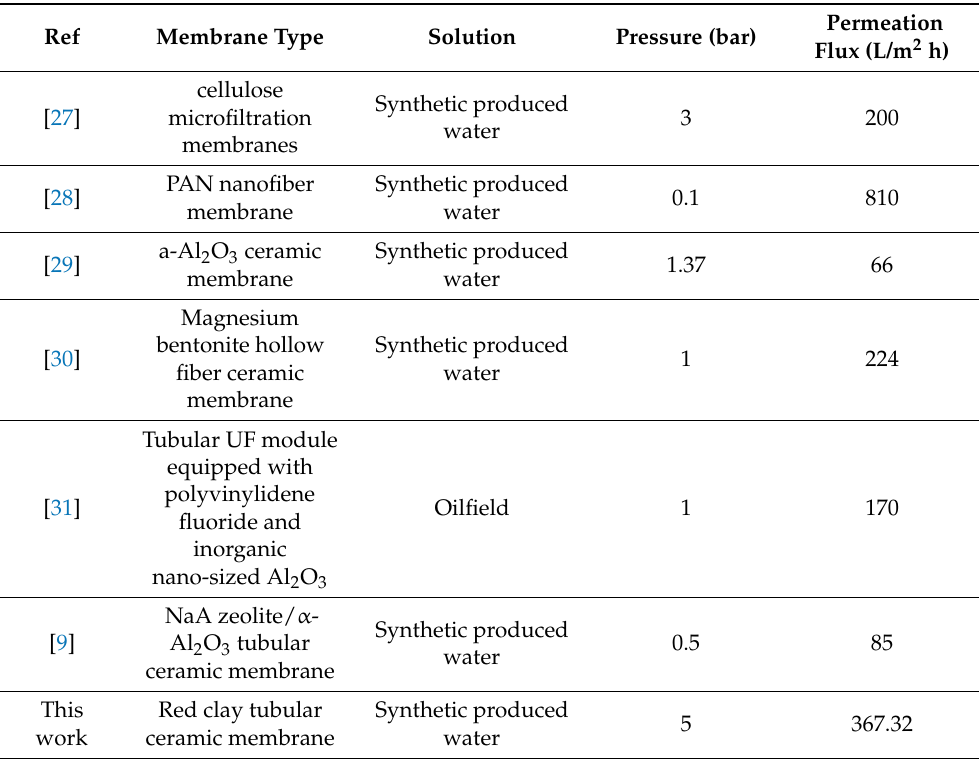
Table 2. Performance comparison of the fabricated membrane in this study with membranes investi- gated in the